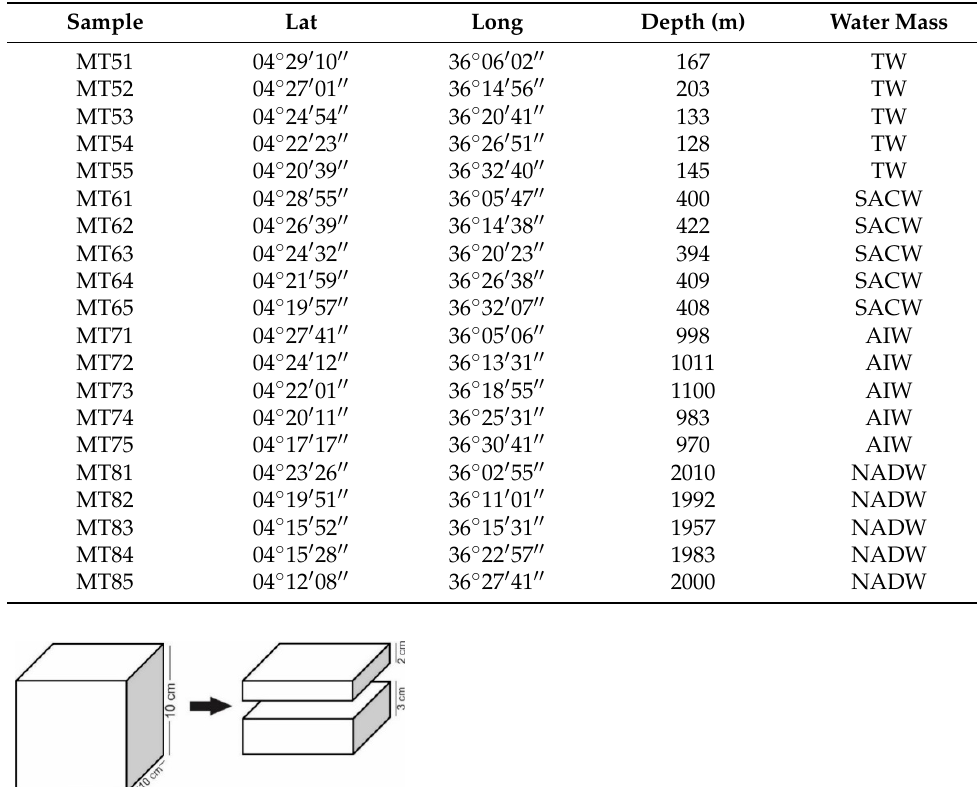
Table 1. Data of sampling stations at the slope of the Potiguar Basin.